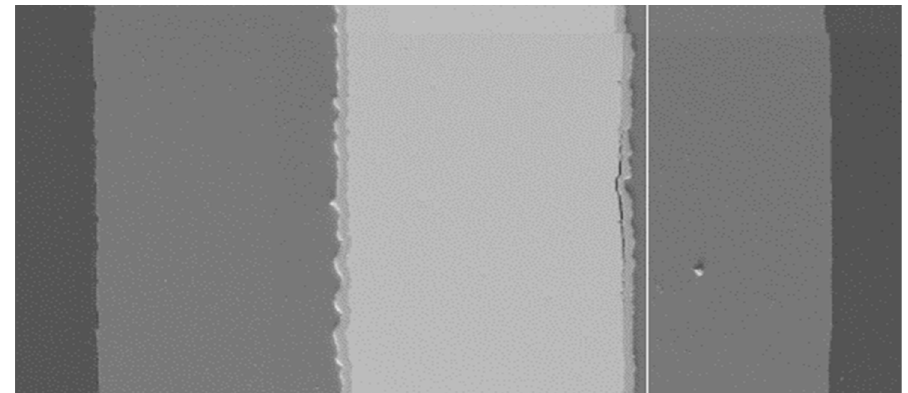
Figure 14. The separation of the DU fuel foil from the electroplated Zr is shown in in the right center portion of the figure. The white line is to emphasize the surface indentation which is most likely due to happenstance.